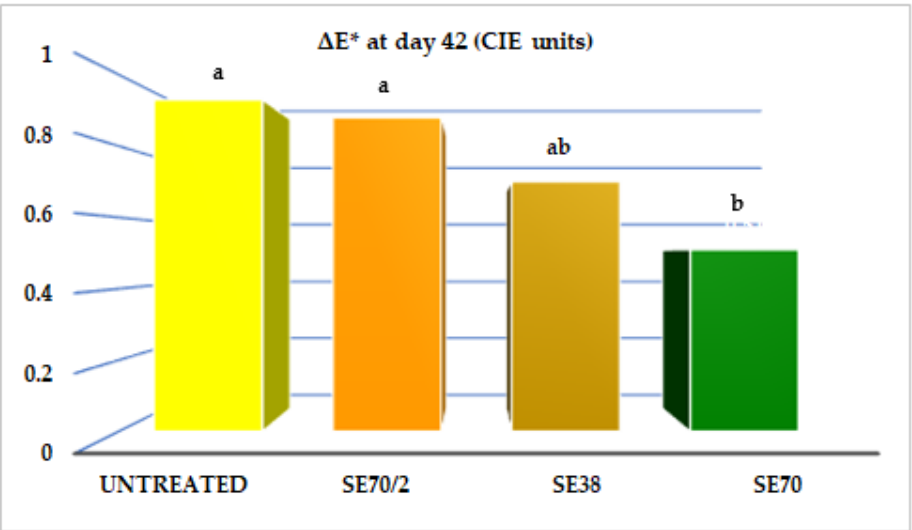
Figure 3. ΔE* colour values of yoghurt sauces enriched with sage extracts (SE70/2, SE38 , and